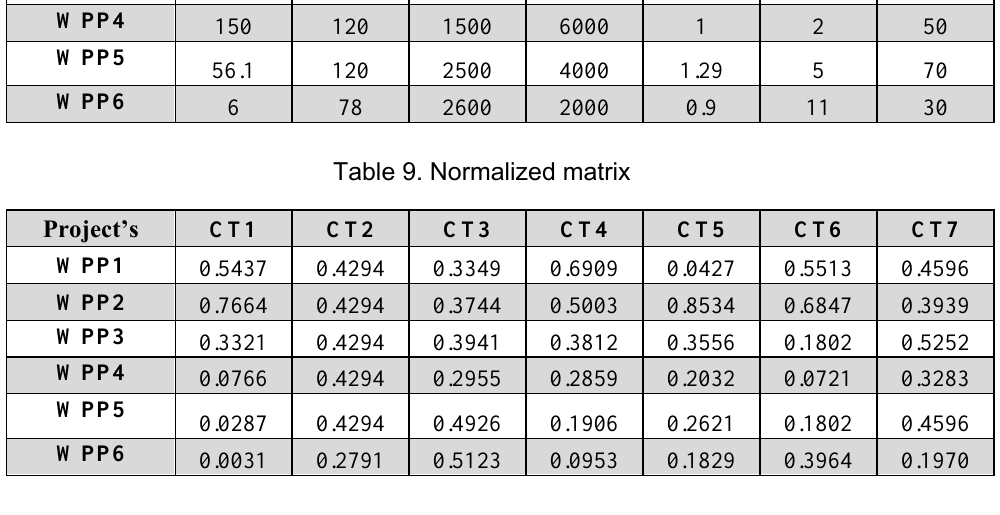
Table 10. Weighted Normalized matrix